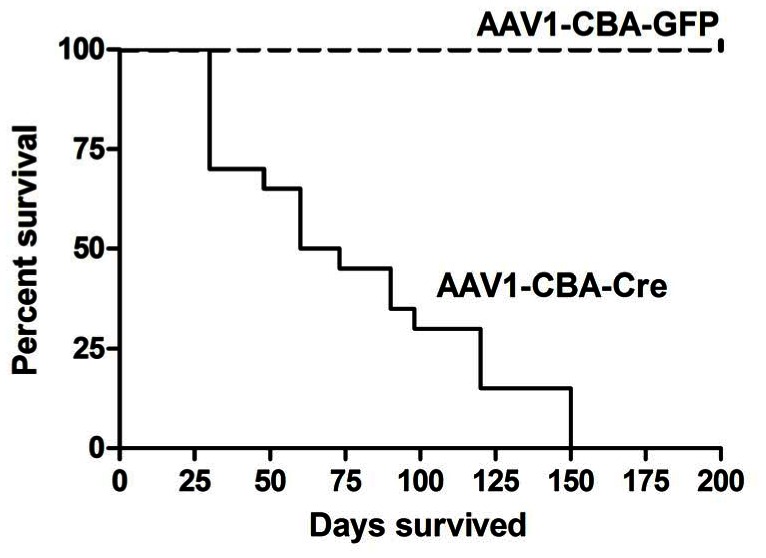
Survival data (Kaplan-Meier curve) of Tsc1c/cROSA mice injected ICV with AAV1-CBA-GFP or AAV1-CBA-Cre at P0.Death was determined by the point at which animals were in severe distress at which time they were euthanized. Tsc1c/cROSApups (N = 20) injected with the AAV-CBA-Cre vector died over a range of 30–150 day postnatal period, with a mean of 66.5 survival days. The same P0 pups injected ICV with AAV-GFP as a control (dashed line) all survived >200 days, the longest time point analyzed (N = 8). p<0.0001.